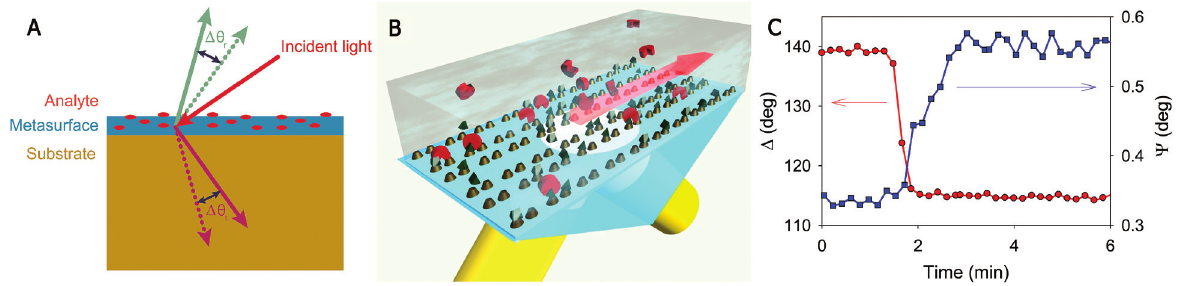
Figure 13 Biosensing with plasmonic metasurface. (A) Analyte-adsorbed metasurface exhibits offsets in the angles of anomalous reflection and refraction, which is subject to the local index change. (B) Schematic of biosensing using a singular-phase nanodot array. (C) Evolution of ellipsometric parameters as biomolecules bind to the functionalized nanodots. The bonding of streptavidin to functionalized Au dots causes a quick change in the phase of reflected light at λ = 710 nm and an incidence angle of 53 ° . (A) is adopted from Ref. [77], and (B) and (C) are adopted from Ref. [177] with